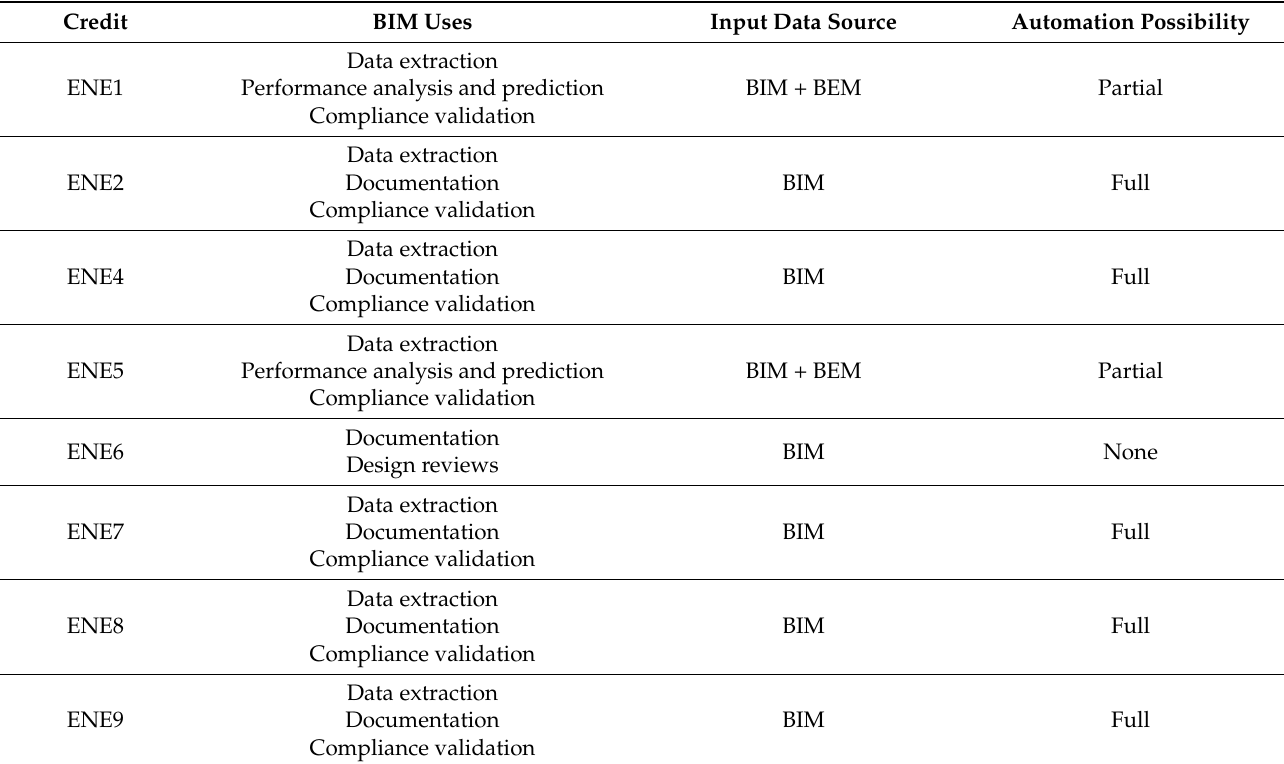
Table 4. BREEAM-NL energy credits vs. BIM